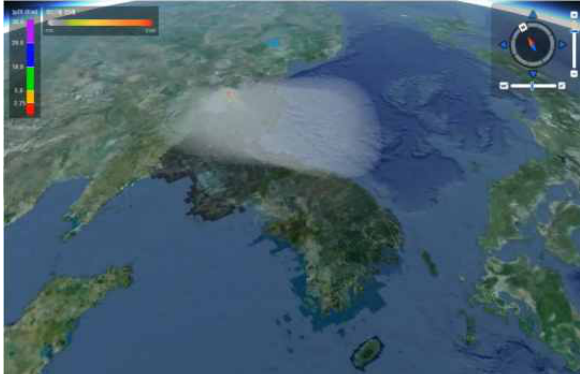
Figure 10. 3D visualization result with "Semi-transparent Volcanic Ash Plane" method -1